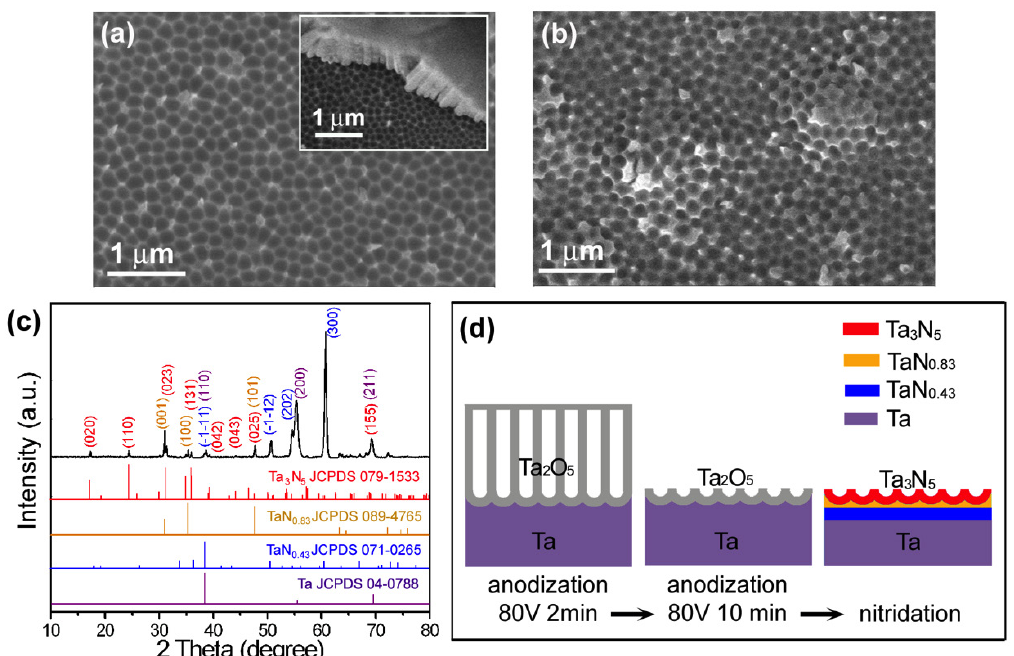
Figure 3. ( a ) The top-view SEM image of the Ta sample anodized at 80V for 10 min (with the inset showing the one anodized at 80V for 2 min). ( b ) The top-view SEM image and ( c ) XRD of the nitrided Ta sample. ( d ) Cross-sections schematic diagrams of the Ta surfaces.